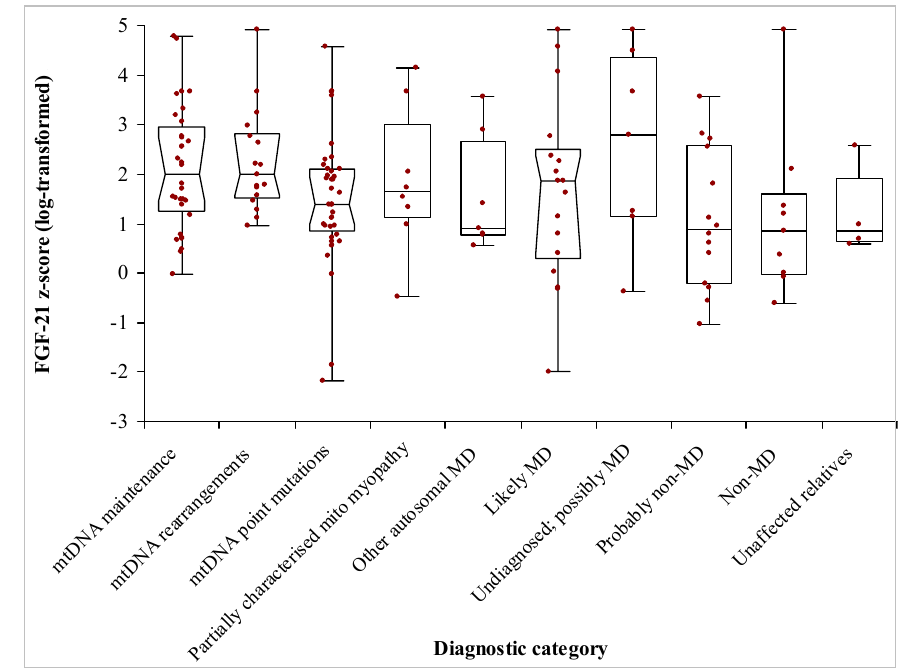
Figure 1. FGF-21 z -scores obtained on specimens from 155 patients investigated for mitochondrial disease. FGF-21 values were normalised by log-transformation, and z -scores were calculated based on age-dependent distributions. Patients were divided into a mitochondrial disease (MD) group consisting of those with mitochondrial DNA or maintenance defects, 30 patients without MD, and 24 patients who were deemed likely to have MD.